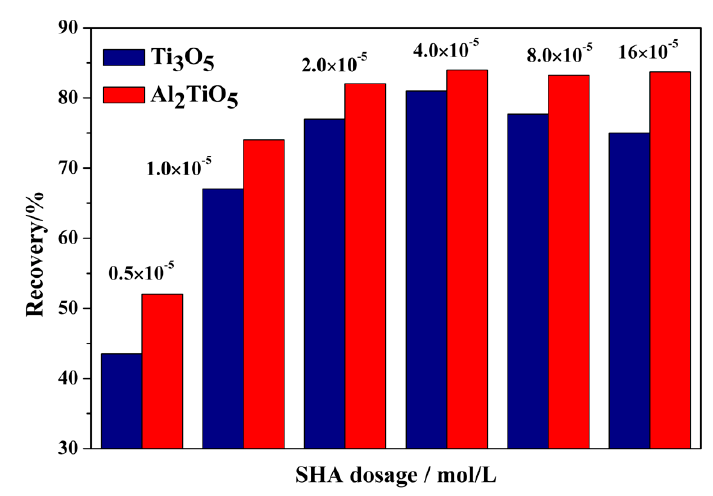
Figure 7. Dosage e ff ect of SHA on the Flotability of Ti 3 O 5 and Al 2 TiO 5 crystals (pH = Figure 7. Dosage effect of SHA on the Flotability of Ti 3 O 5 and Al 2 TiO 5 crystals (pH = 7).